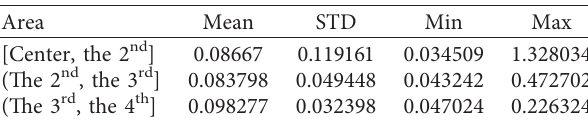
Figure 10: Spatial distribution of C.V. in grid accessibility. The brown grid indicates higher C.V., while gold grid indicates lower C.V. Table 4: Information about CV.